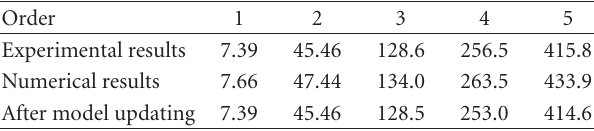
Table 1: Natural frequencies of cantilever beam